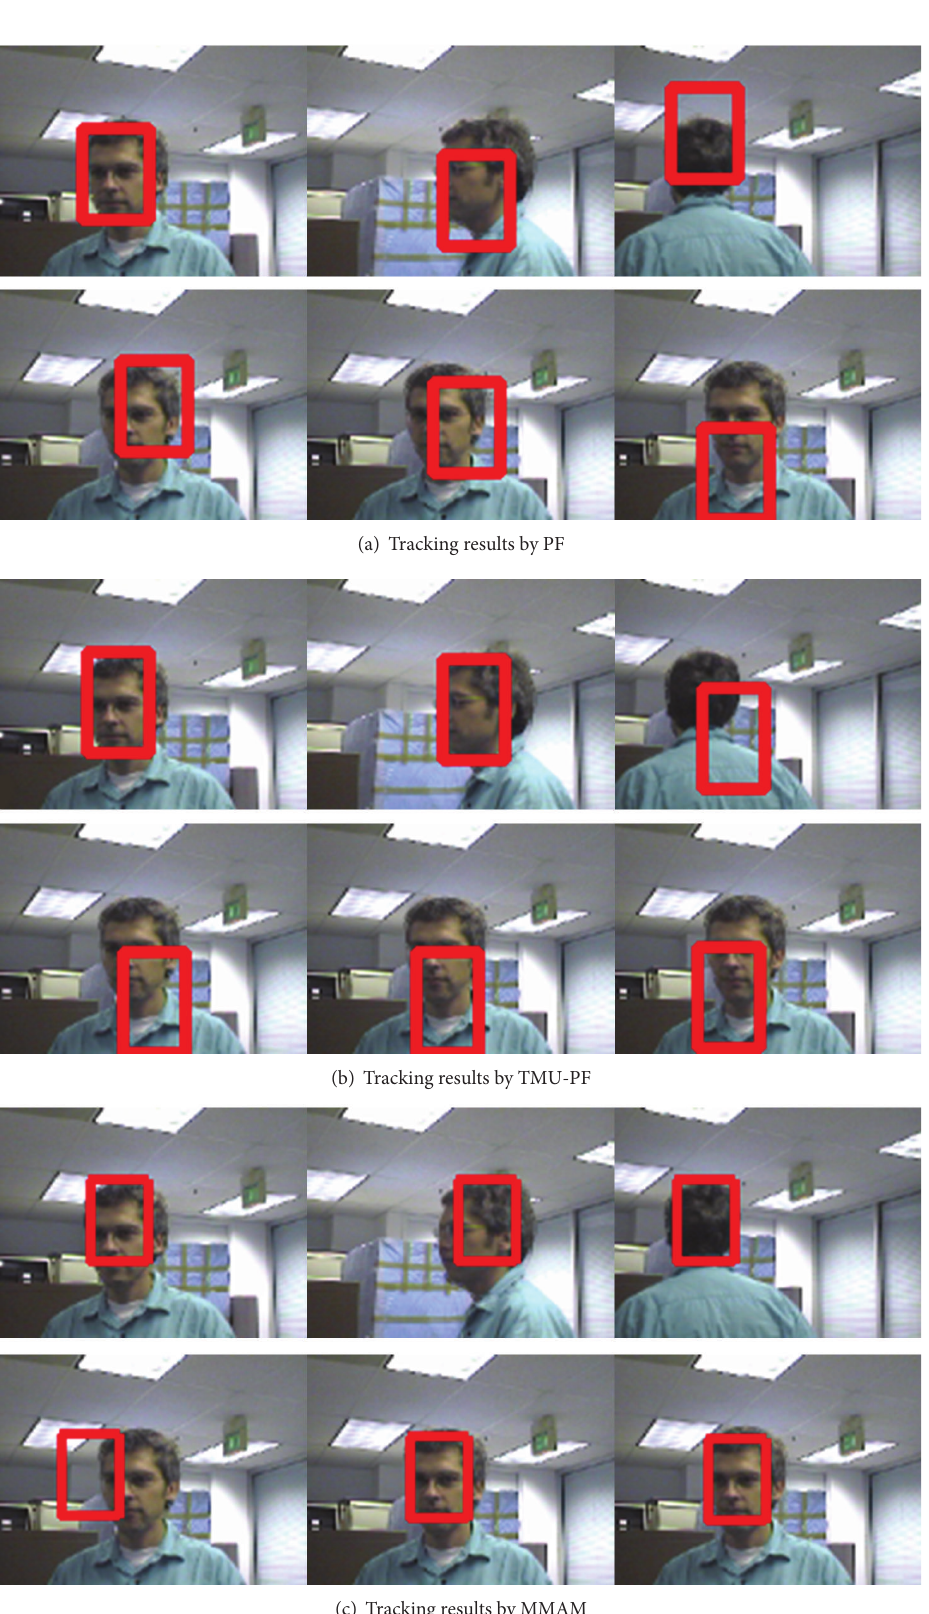
Figure 10: Tracking results of “seq dk”